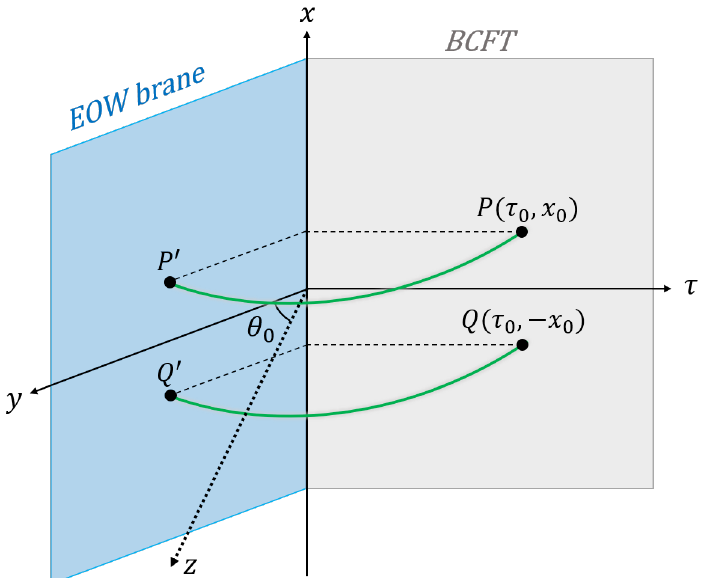
Figure 15. The disconnected phase in terms of ( τ, x, z ) coordinates. Extremal surfaces are repre- sented by green